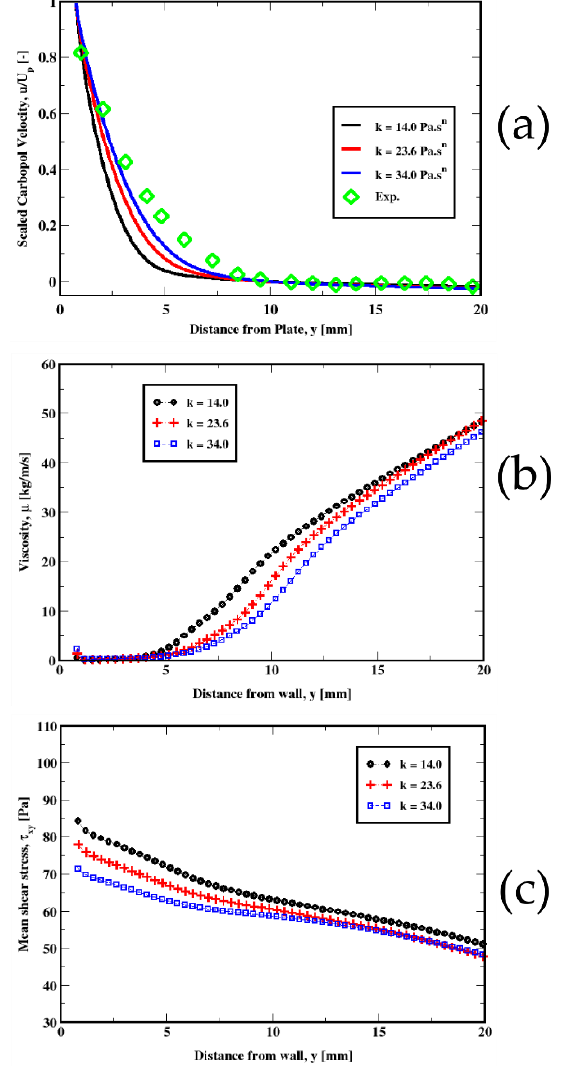
Figure 14. Influence of the consistency index on the distribution of the velocity of the Carbopol fluid (top plot) ( a ) for the plate immersion velocity of 1 mm/s. The middle ( b ) and the bottom ( c ) plots represent the variation in the kinematic viscosity and the mean shear stress, respectively.